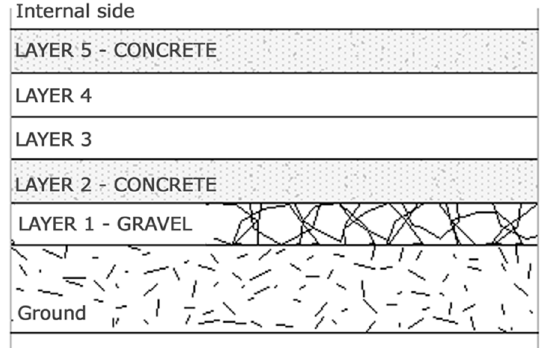
Figure 6. Case 2: Stratification of slab-on-ground floor with gravel.